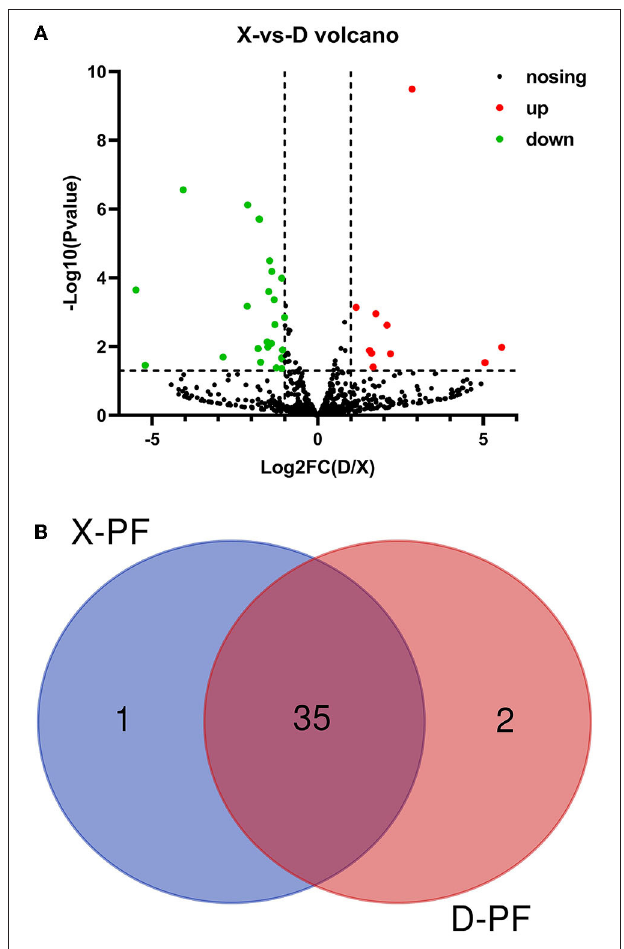
FIGURE 3 | Differential expression of miRNA. (A) Volcano map of differentially expressed miRNAs. The scatter in the figure represents the miRNAs, the black dots indicate the miRNAs with no significant differences, the red dots indicating a significant up-regulation of the miRNA, and the green dots represent a significant down-regulation of the miRNA. (B) The miRNA Venn diagram was differentially expressed in the two groups. D-PF represented the subcutaneous adipose tissue of Duolang sheep, X-PF represented the subcutaneous adipose tissue of Small Tail Han